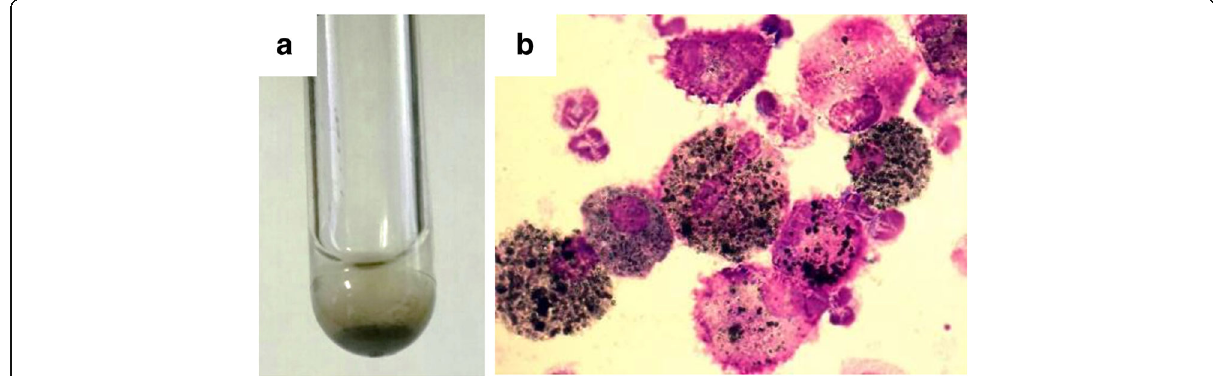
Fig. 5 Exposure to carbonaceous particles from biofuel burning. a Carbon loading was visible as blackened BALC pellets. b Particles were mainly contained in alveolar macrophages of blackened